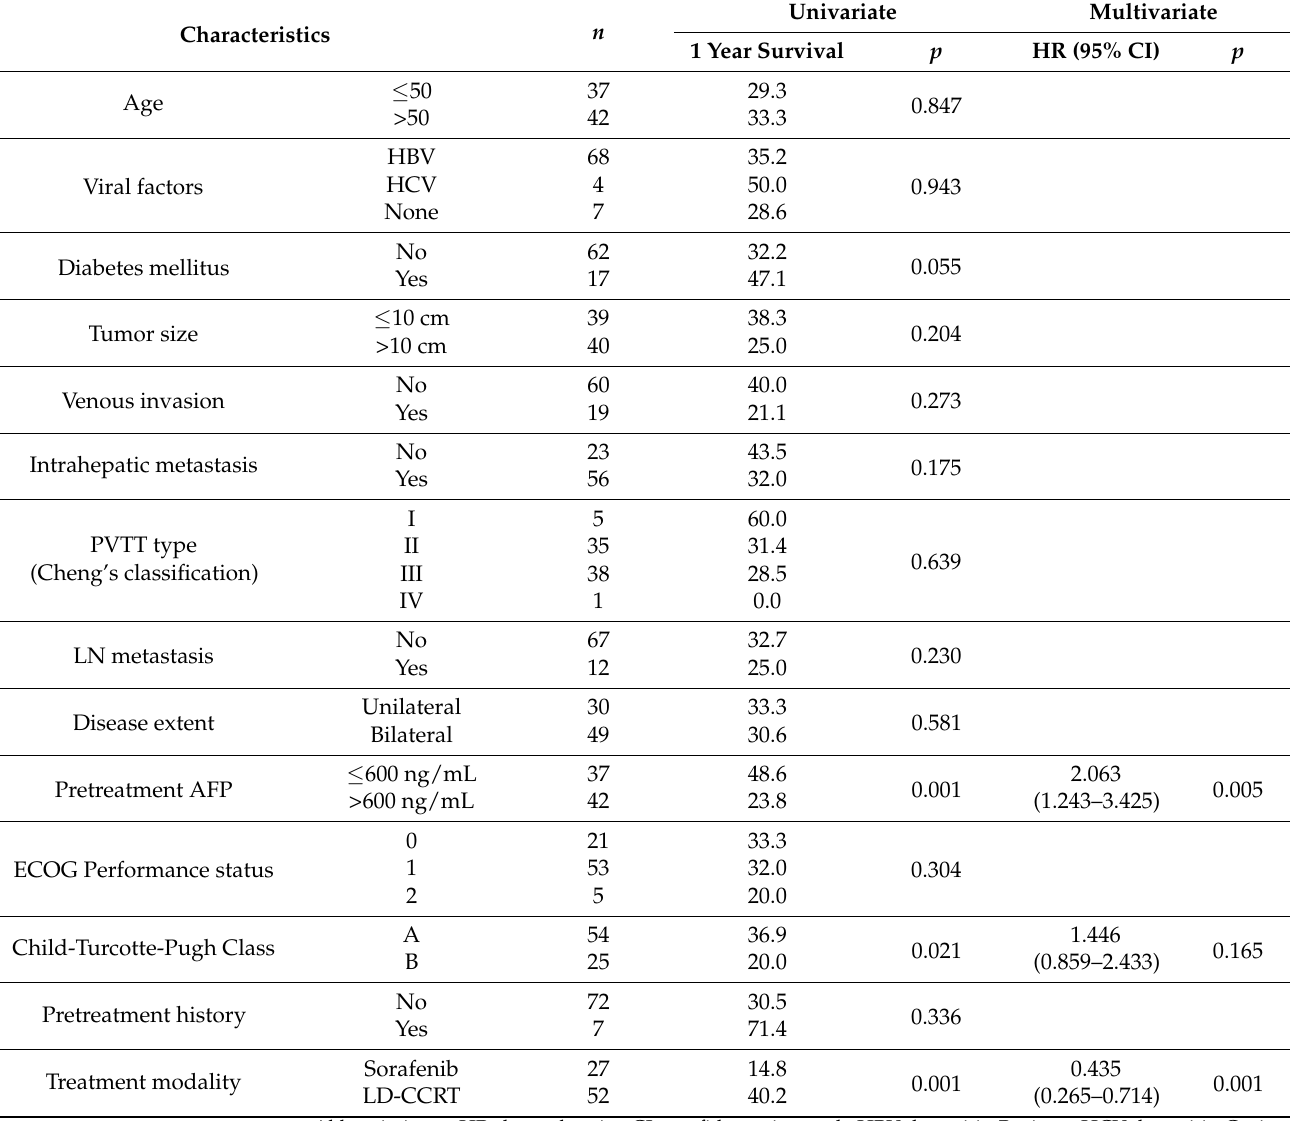
Table 2. Prognostic factors for overall survival in the propensity score-matched